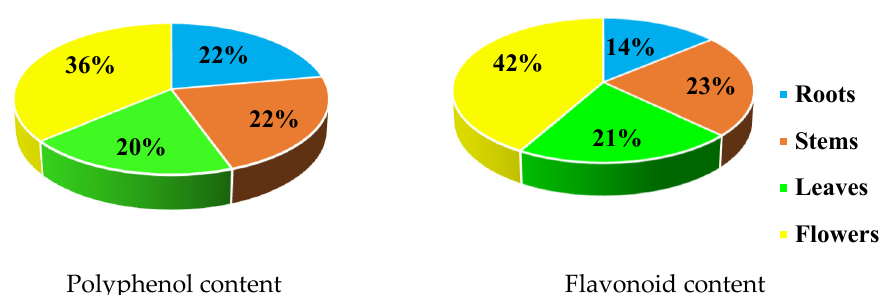
Figure 6. Percentage of polyphenols and flavonoids in methanolic extracts of Cladanthus mixtus . The total phenolic content of the C. mixtus flower extract found in this work (30.55